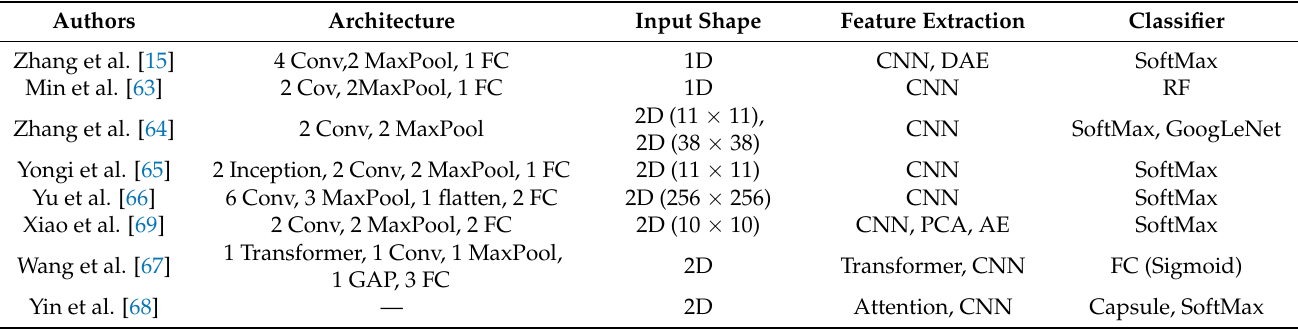
Table 10. Architectural properties of group 3 (Hybrid CNN and Deep Learning) IDS schemes.